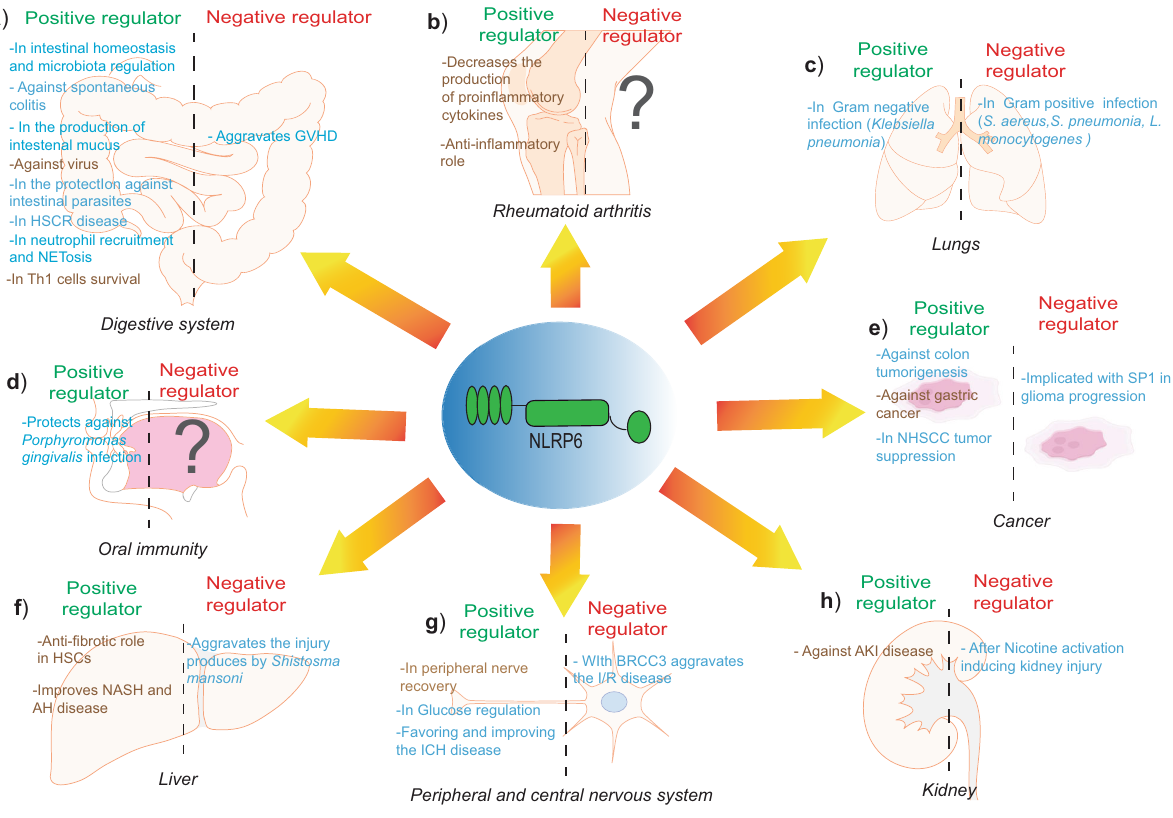
Fig. 2 Roles of NLRP6 in different organs and tissues. Schematic representation of the different functions of NLPR6 in a the digestive system, b joints, c lungs, d oral cavity, e cancer, f liver, g peripheral and central nervous system, and h kidney. Functions shown in blue represent the NLRP6 in fl ammasome- dependent response and functions shown in brown represent the NLRP6 in fl ammasome-independent response. Illustrations were partially created using templates from www.motifolio.com (Motifolio Inc, Ellicott City,